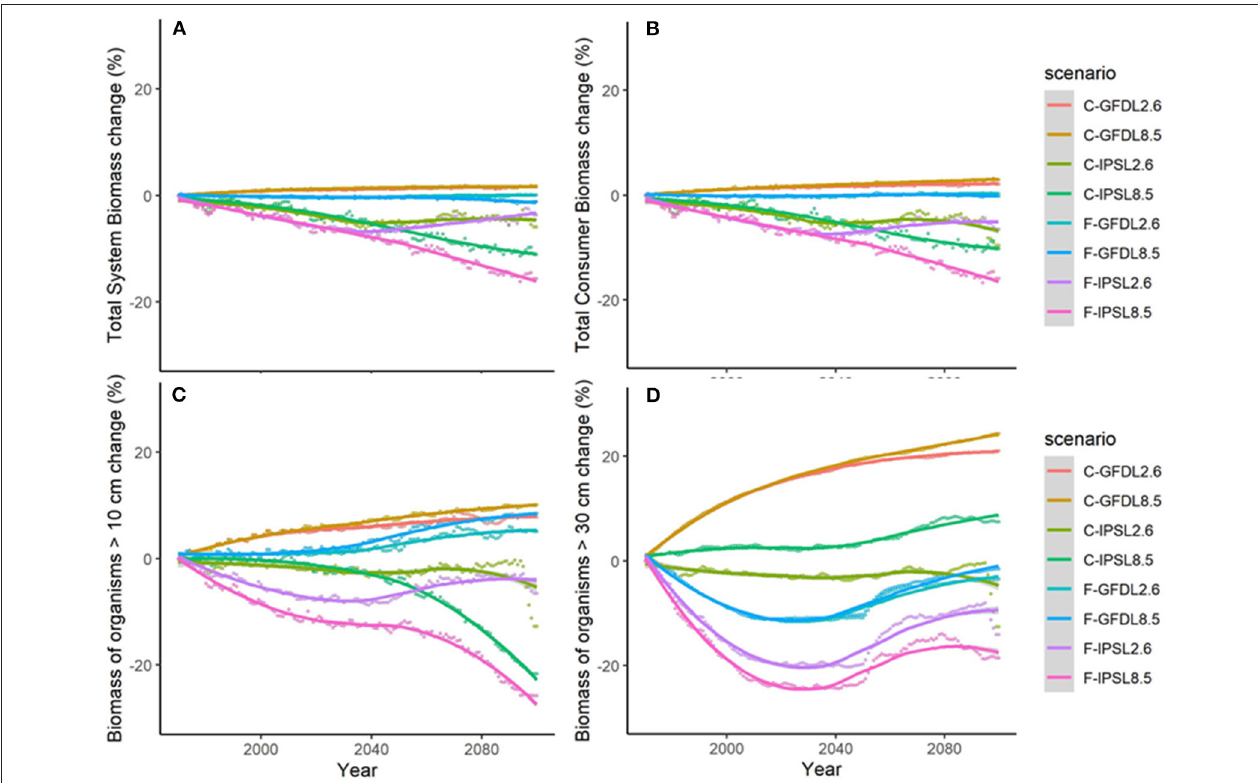
FIGURE 5 | Experiment 2 (Climate impacts) and 3 (Climate impacts and fishing impacts) ( Table 1 )—Relative temporal change of ecological indicators (%): (A) Total System Biomass, (B) Total Consumer Biomass, (C) Biomass of organisms > 10cm, and (D) Biomass of organisms >